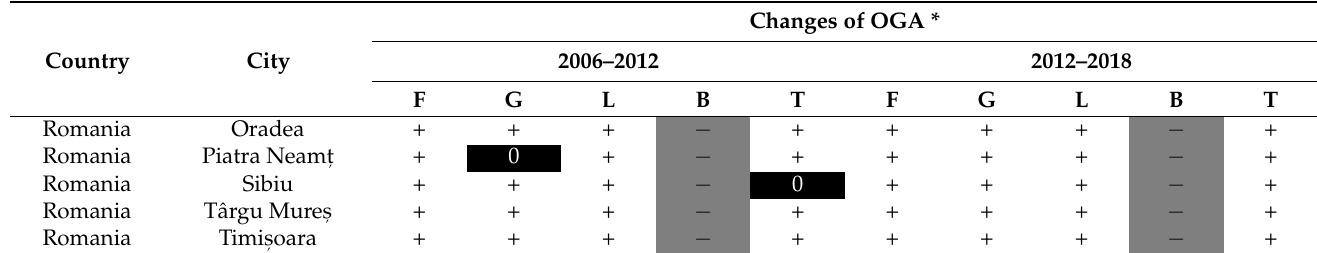
* Positive values (white shading) indicate that the difference between final and initial data is positive, indicating that fragmentation increased in intensity: (column labeled “F”, standing for “Fragmentation”), some OGA were gained (column labeled “G”, meaning “Gain”), some OGA were lost (column labeled “L”, from “Loss”), more OGA were gained than lost (column labeled “B”, for “Balance”), and OGA suffered inner changes (column labeled “T”, i.e., “Transformation”). Negative values (gray shading) indicate the contrary, and 0 (black shading) shows no change.